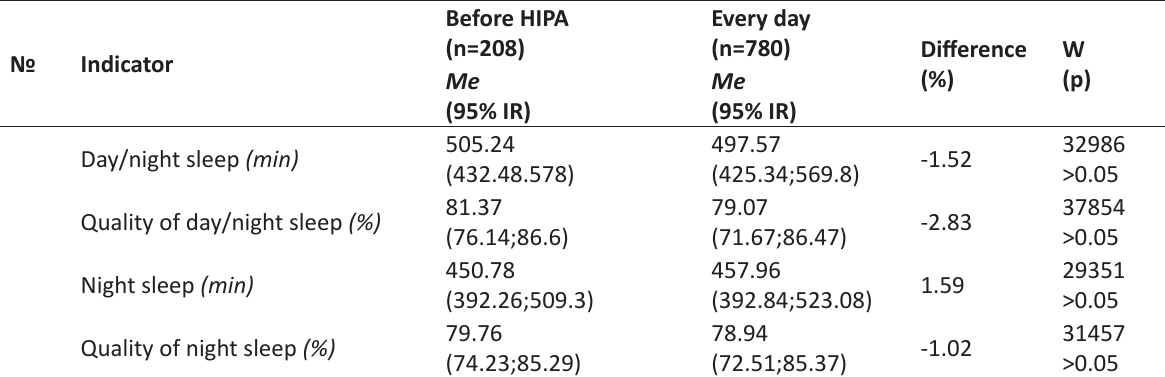
Table 4. Comparison of sleeping regimes before highly intensive physical activity and every day